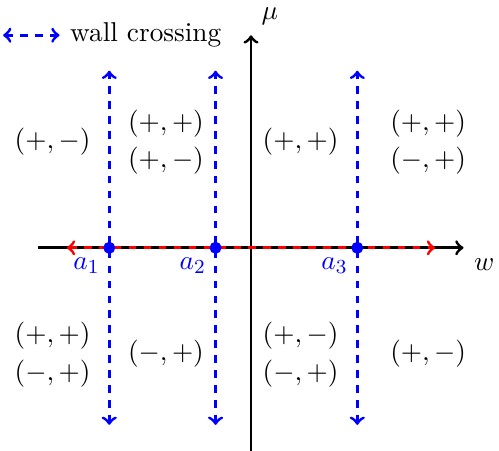
ˆ λ > 0 . The vacua are defined in table 1. The are a = a − 1 = − 2 −| ˆ λ | and a = 2+ | ˆ λ | . There is a second order phase i 1 3 2 | ˆ λ | | ˆ λ |